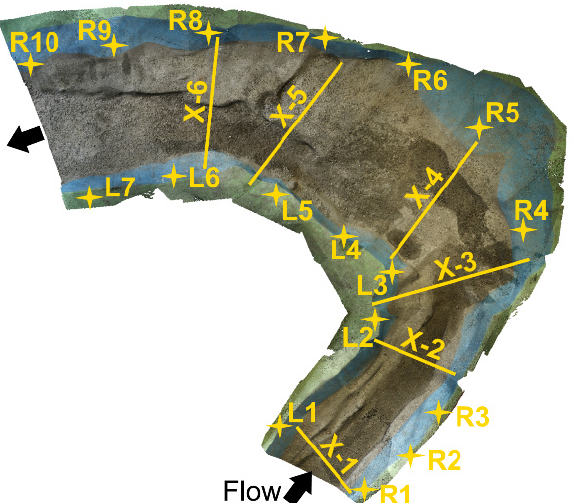
Figure 1. Trishuli River model with locations of 17 GCPs (R1-R10 in the right bank and L1-L7 in the left bank) and 6 measurement cross-sections (X-1 to X-6). The figure shows the fixed bed river model which is then filled with mobile sediment bed.